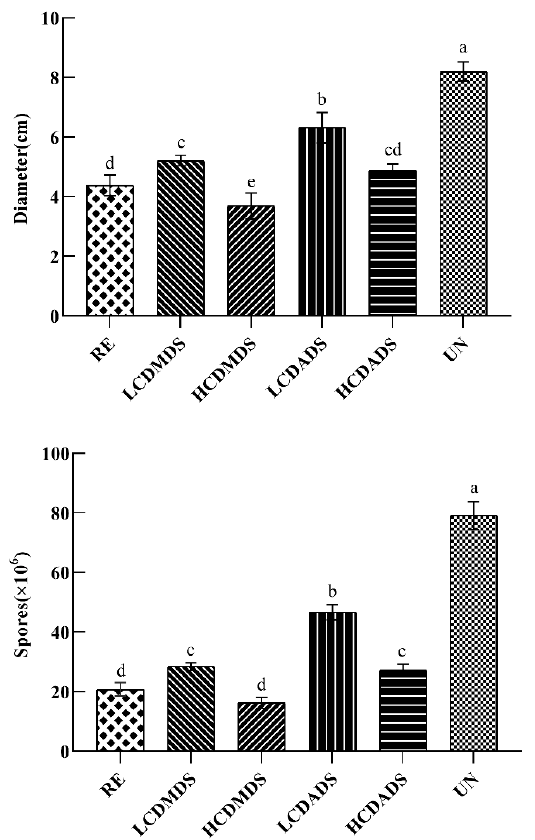
Figure 7. The effect of the sulfur compounds and root exudates of A. fistulosum L. on the growth of the Fusarium solani isolate HBH 08 and on the spore germination of the Fusarium solani isolate HBH 08. RE, A. fistulosum L. root exudates by hydroponics; LCDMDS, measured concentrations of DMDS (22.4 µ g/mL); HCDMDS, 5 times the measured concentration of DMDS (112 µ g/mL); LCDADS, measured concentrations of DADS (15.2 µ g/mL); HCDADS, 5 times the measured concentration of DADS (76 µ g/mL); and UN, untreated replanted soil (control). Different letters (a, b, c, d, and e) indicate statistically significant differences according to Tukey’s HSD test ( p ≤ 0.05). Table 4. Effect of root exudates A. fistulosum L. on the growth of M. hupenhensis Rehd. seedlings.